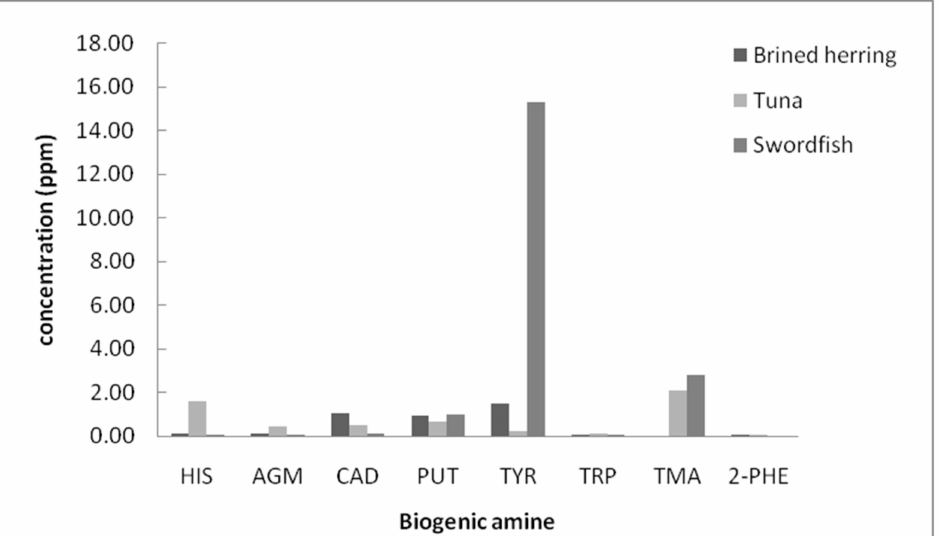
Figure 4. Concentrations of some biogenic amines in brined herring, fresh tuna, and swordfish. HIS: Histamine, AGM: Agmatine, CAD: Cadaverine, PUT: Putrescine, TYR: Tyramine, TRP: Tryptamine, TMA: Trimethylamine, 2-PHE: